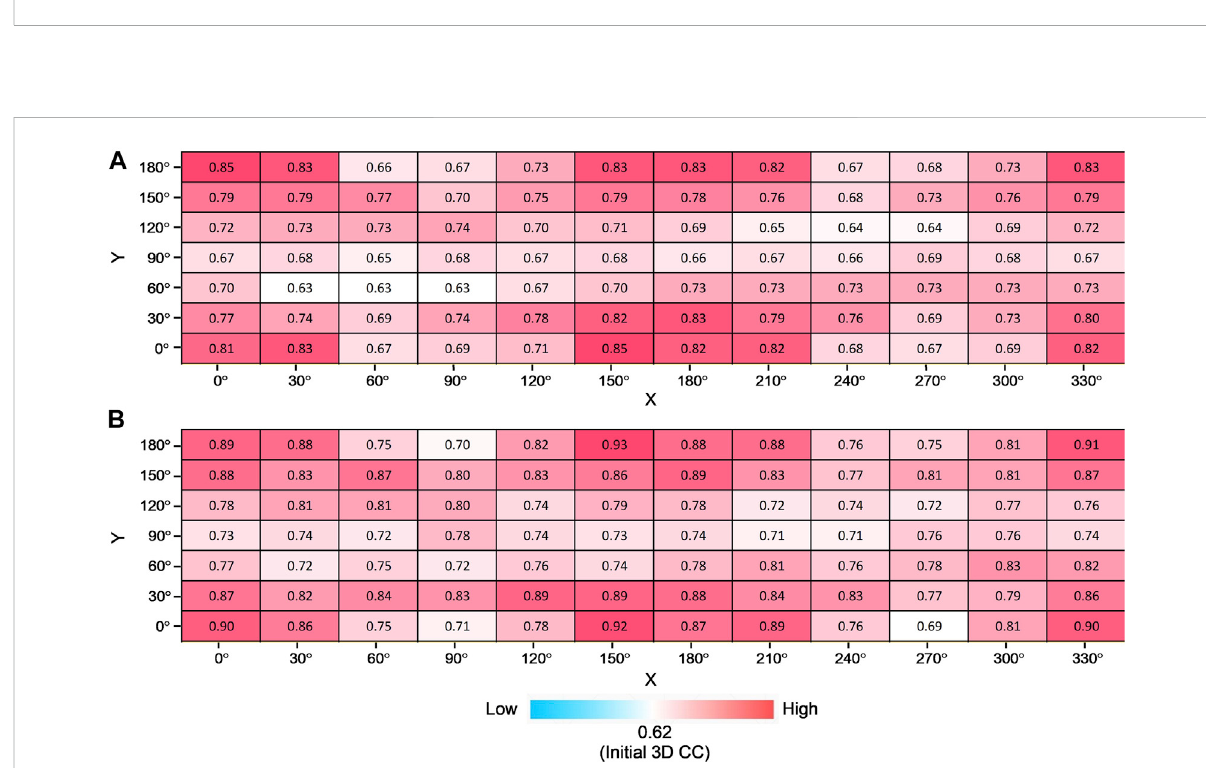
FIGURE 8 ModelingEF2fromdifferentorientations.Average (A) andthehighest (B) fi nal3DCCfortentrajectoriesforallcombinationsofrotationdegrees by X-axis and Y-axis with the color